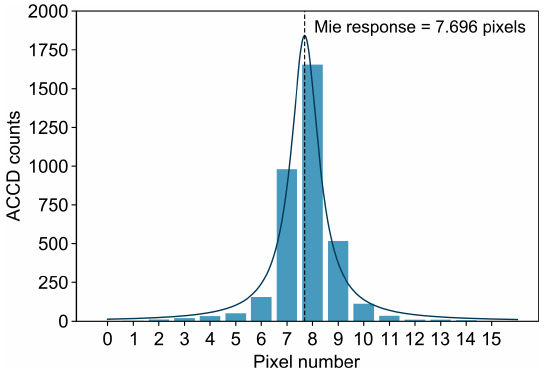
Figure 2. Internal reference path Mie signal for one laser pulse (24 November 2020, 0:23:47UTC). After vertical integration of im- aged fringe on the Mie ACCD (see also Fig. 1), the signal is dis- tributed over 16 pixels (blue bars). A Nelder–Mead downhill sim- plex algorithm is applied to determine the centroid position from a Lorentzian line shape fit (dark-blue